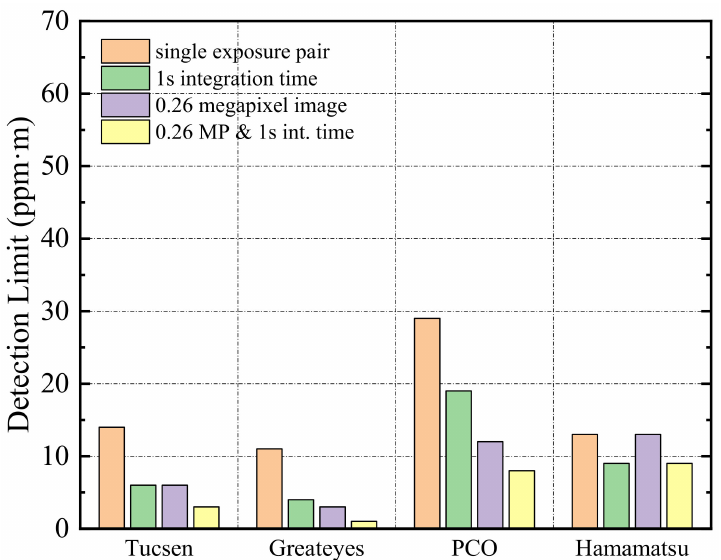
Figure 12. The detection limits of different camera systems under ideal conditions (Distance = 0 km). The first bar is the detection limit of a single exposure. The second and third bars represent the detection limit for a total integration time of 1 s and 0.26-megapixel image (512 × 512 pixels), respectively. The final bar is the detection limit of the 0.26-megapixel image after 1 s